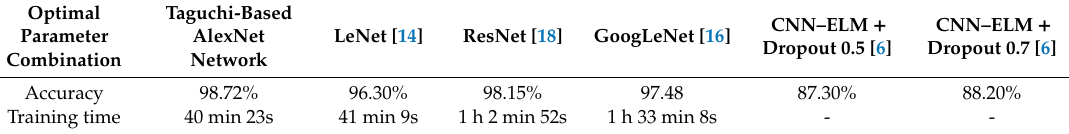
Table11. ComparisonresultsofaccuracyandtrainingtimeusingvariousmethodsintheMORPHdatabase. Optimal